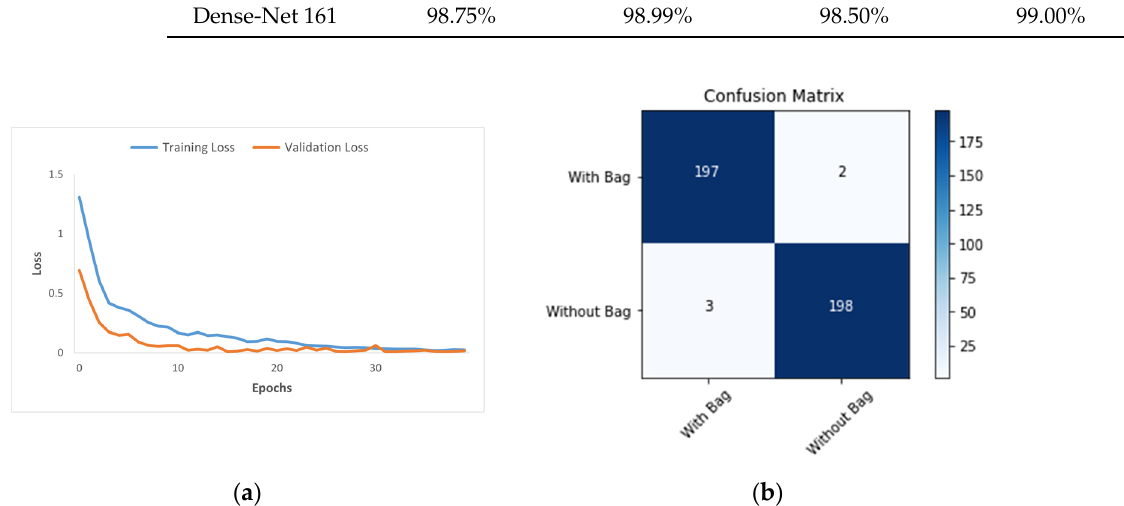
Table 9. The evaluation results of the second experiment on INRIA, ILIDS, and MSMT17 datasets. Network